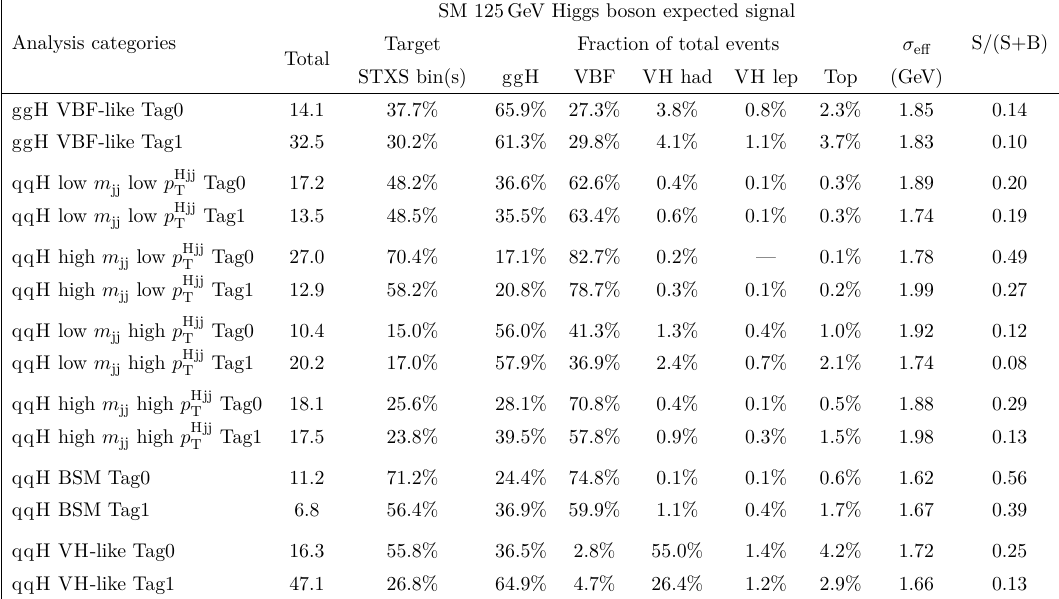
= 125 GeV in analysis categories targeting Table 5 . The expected number of signal events for m H VBF-like phase space and VH production in which the vector boson decays hadronically, shown for an integrated luminosity of 137 fb − 1 . The fraction of the total number of events arising from each production mode in each analysis category is provided, as is the fraction of events originating from the targeted STXS bin or bins. Entries with values less than 0.05% are not shown. Here ggH includes contributions from the ggZ(qq)H and bbH production modes, whilst “Top” represents both ttH and tH production together. The σ , defined as the smallest interval containing 68.3% eff of the m distribution, is listed for each analysis category. The final column shows the expected gg ratio of signal to signal-plus-background, S/(S+B), where S and B are the numbers of expected signal and background events in a ± 1 σ window centred on m eff H